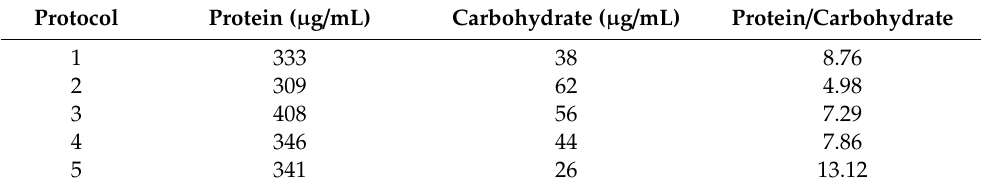
Table 3. Total protein and carbohydrate concentrations in vesicle extract samples determined by colorimetric BCA and carbohydrate assays. The five cationic extraction protocols yielded di ff erent quantities of protein and carbohydrate. The protein concentration of the anionic vesicles was not tested